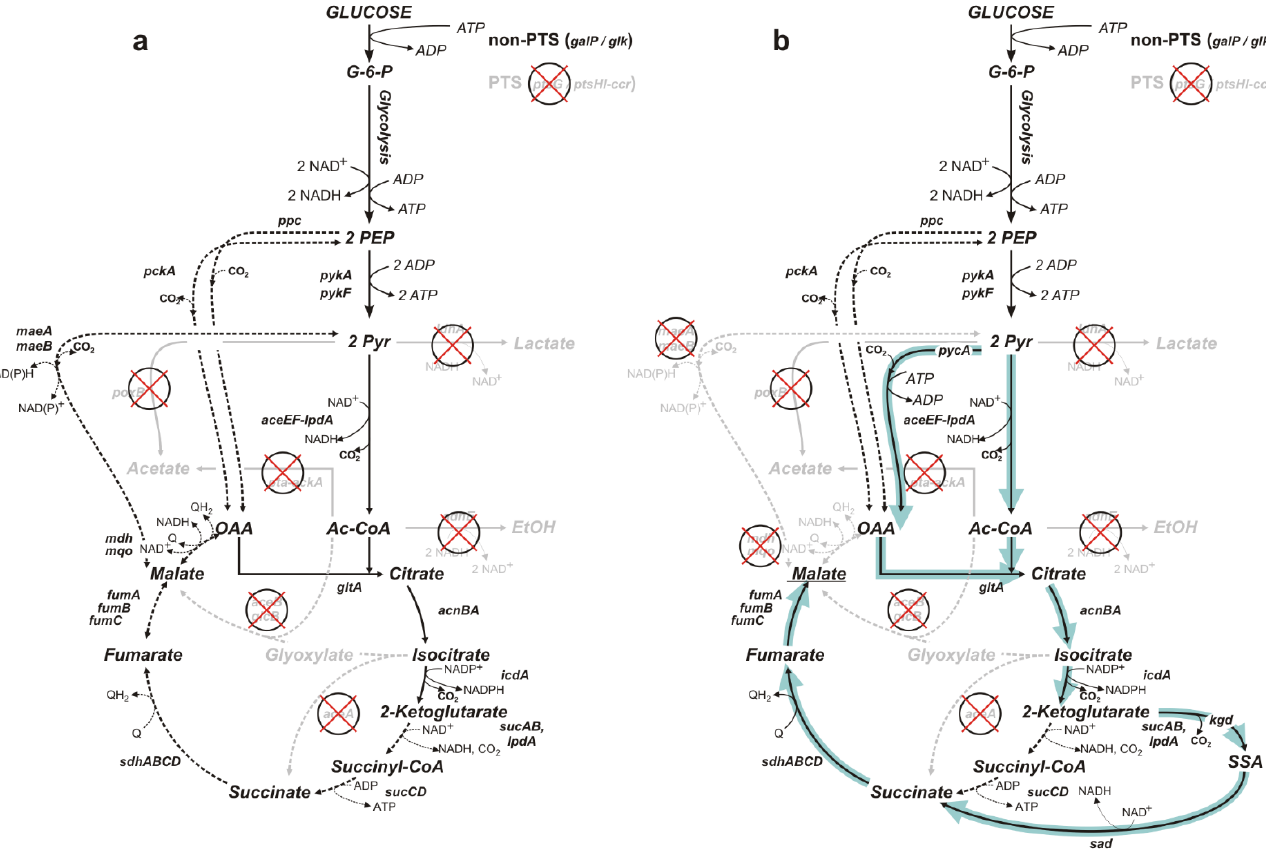
Figure 1. Central carbon metabolism in engineered E. coli strains under aerobic conditions with glucose as a carbon source. ( a ) The core strain MAL 0; ( b ) The best-performing malic acid-producing strain MAL 4MPA [pMW- kgd ]. The enzymes are indicated by their gene names. Heterologous genes and enzymes are as follows: kgd , M . tuberculosis 2-ketoglutarate decarboxylase; pycA , B. subtilis pyruvate carboxylase. Abbreviations of key metabolites in the pathways are Ac-CoA , acetyl-CoA; G-6-P, glucose-6-phosphate; OAA , oxaloacetate; PEP , phosphoenolpyruvate; Pyr , pyruvate; SSA , succinate semialdehyde. The deleted genes are marked with crossed circles. Dotted arrows indicate reactions with decreased intensity. The reactions, as well as the genes of the respective enzymes, substrates, products, and cofactors that are absent or inactive in the constructed strains, are shown in grey. The reactions of the artificial pathway of malic acid biosynthesis, starting from pyruvate and including shunting of 2-ketoglutarate to succinic acid via intermediate SSA formation, which was engineered in the current study, are highlighted by wide blue